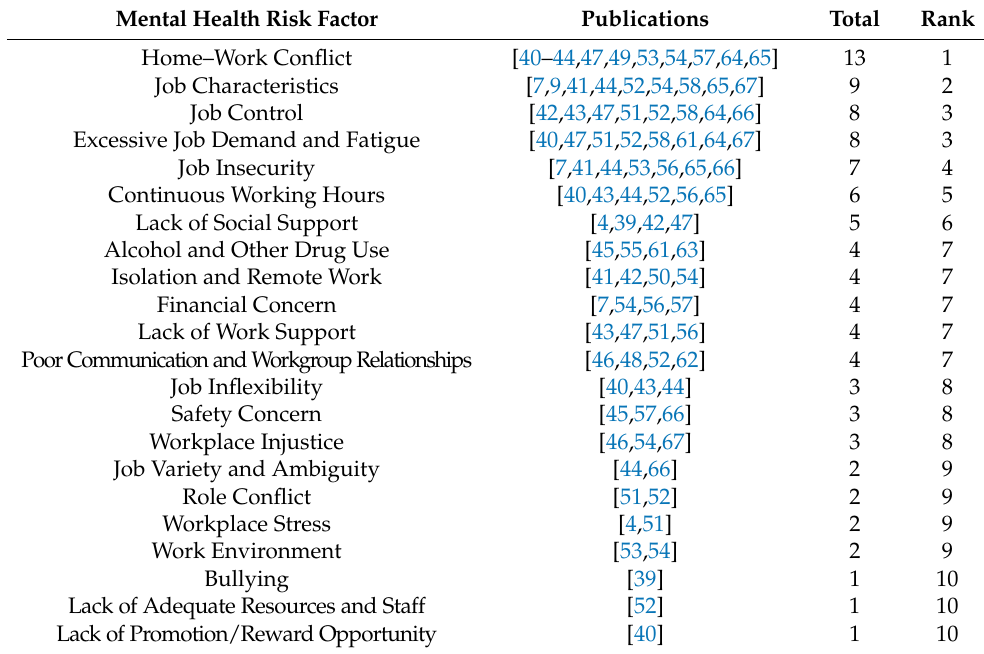
Table 2. Mental health risk